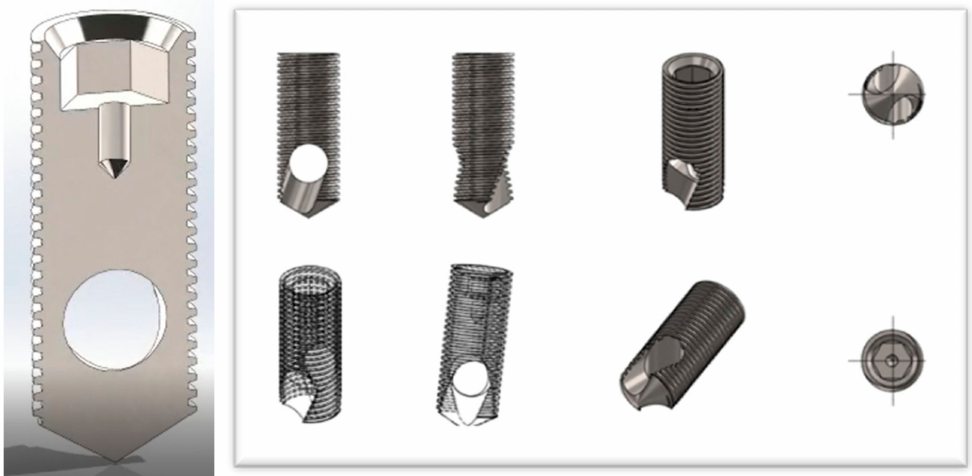
Figure 1. BKS of 4 mm width and 10 mm length, according to the authors project